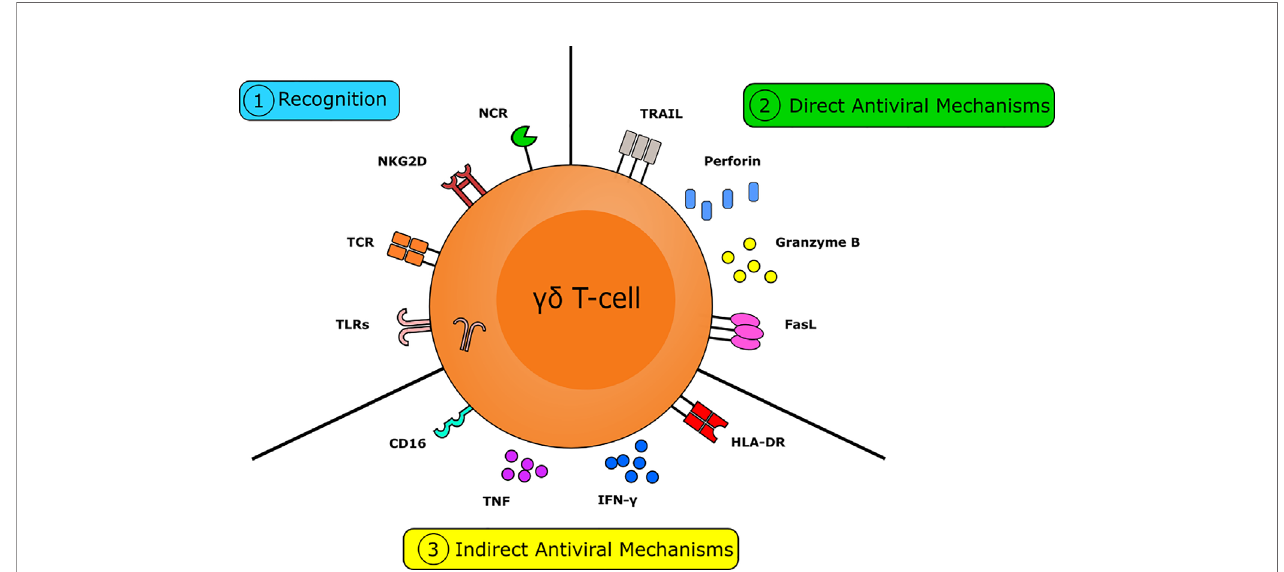
FIGURE 1 | The multifactorial capacity for the gd T-cell to interact with viruses and virally infected targets. Numerous pathways are crucial in the gd T-cell mediated antiviral response. gd T-cells are capable of rapidly recognizing virally infected cells. This can occur via the detection of isopentenyl pyrophosphate (IPP) by the T-cell receptor (TCR), via recognition of stress-induced molecules by NKG2D, or via the recognition of viral molecules and PAMPs by NK-type receptors and TLR, respectively. gd T-cells have numerous mechanisms to directly combat viral infection. Direct antiviral mechanisms are mediated by cytolytic molecules, such as perforin and granzyme B, to induce cytolysis and by the expression of death receptors, including FasL and TRAIL, to induce apoptosis. gd T-cells also have several indirect mechanisms capable of combatting viral infection. Indirect antiviral mechanisms are mediated by cytokines, such as IFN g and TNF, by the expression of MHC-II allowing them to act as APC to direct the adaptive immune response and via expression of CD16 to trigger antibody-dependent cellular cytotoxicity. Together these actions make the gd T-cell a crucial component in the immune response to